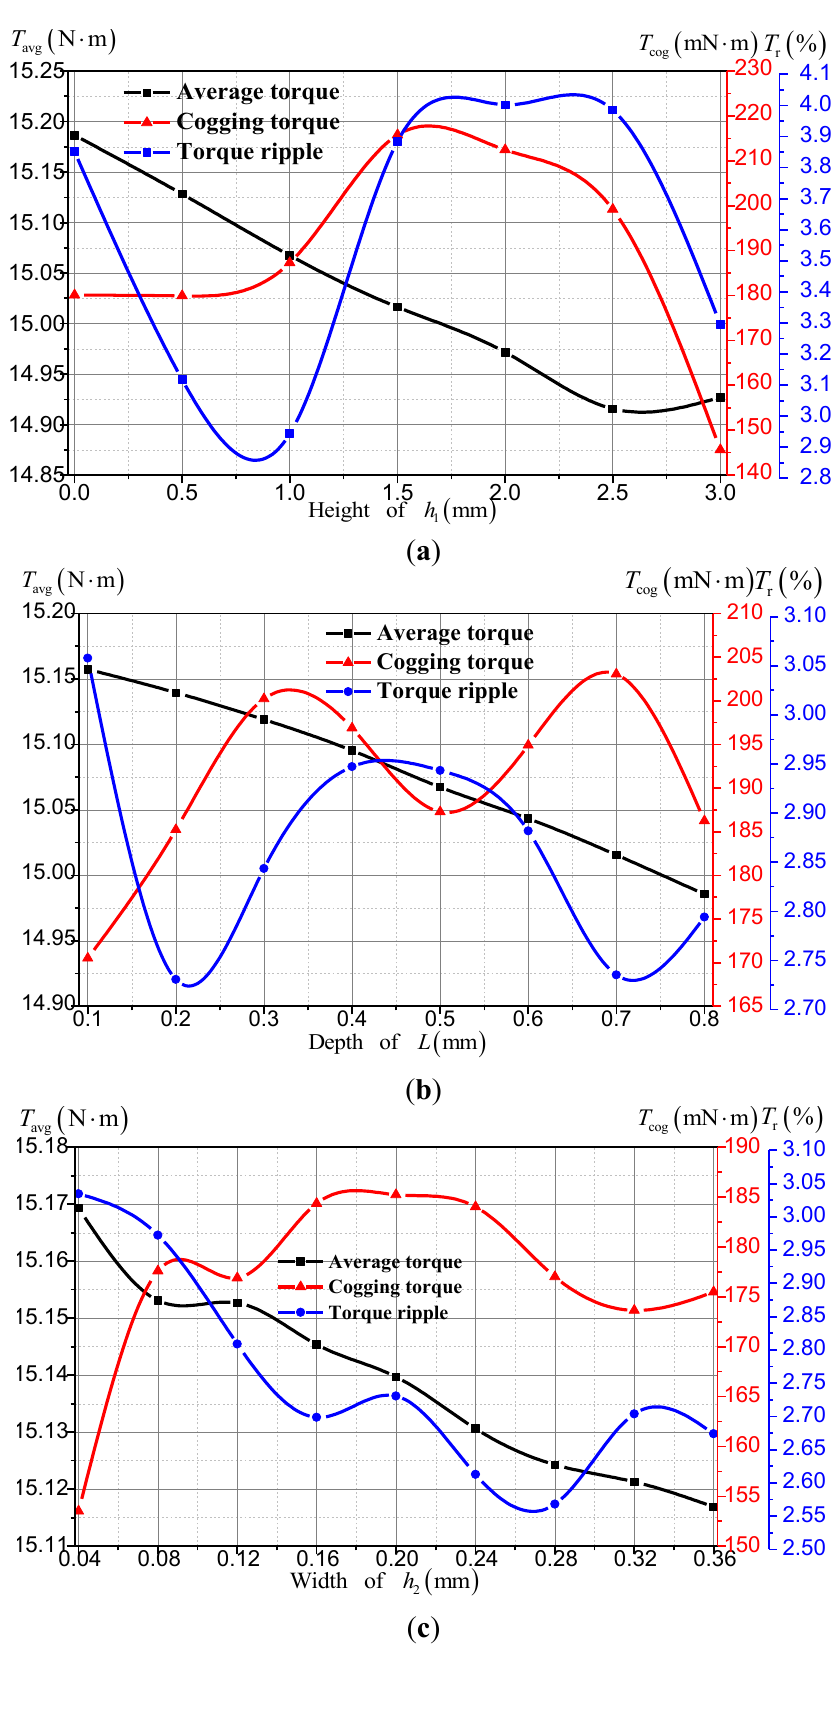
Figure 14. Average torques, torque ripples, cogging torques according to: ( a ) the height of h 1 ; ( b ) the depth of L ; and ( c ) the width of h 2